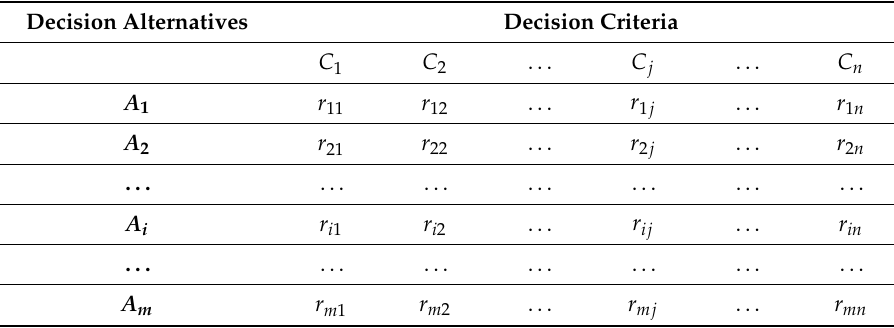
Table 5. Normalized Decision Matrix (NDM).